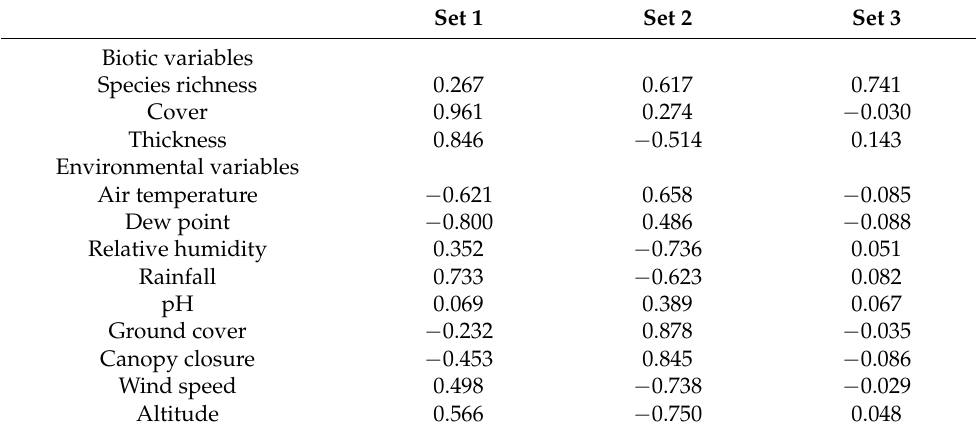
Table A5. Canonical loadings for biotic and environmental variables.